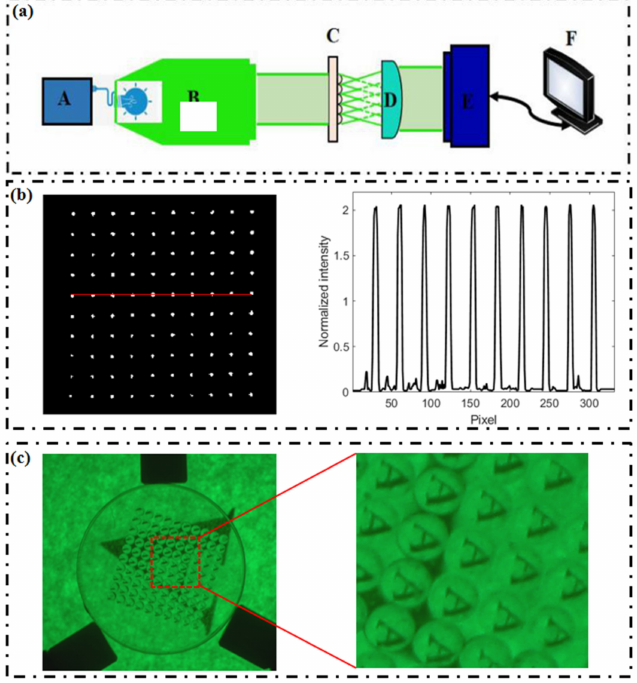
Figure 8. ( a ) The schematic diagram of optical imaging platform, ( b ) focus imaging and intensity data captured by CCD camera of PMMA microlens array, and ( c ) the capital letter “A” focused on the aspheric lens